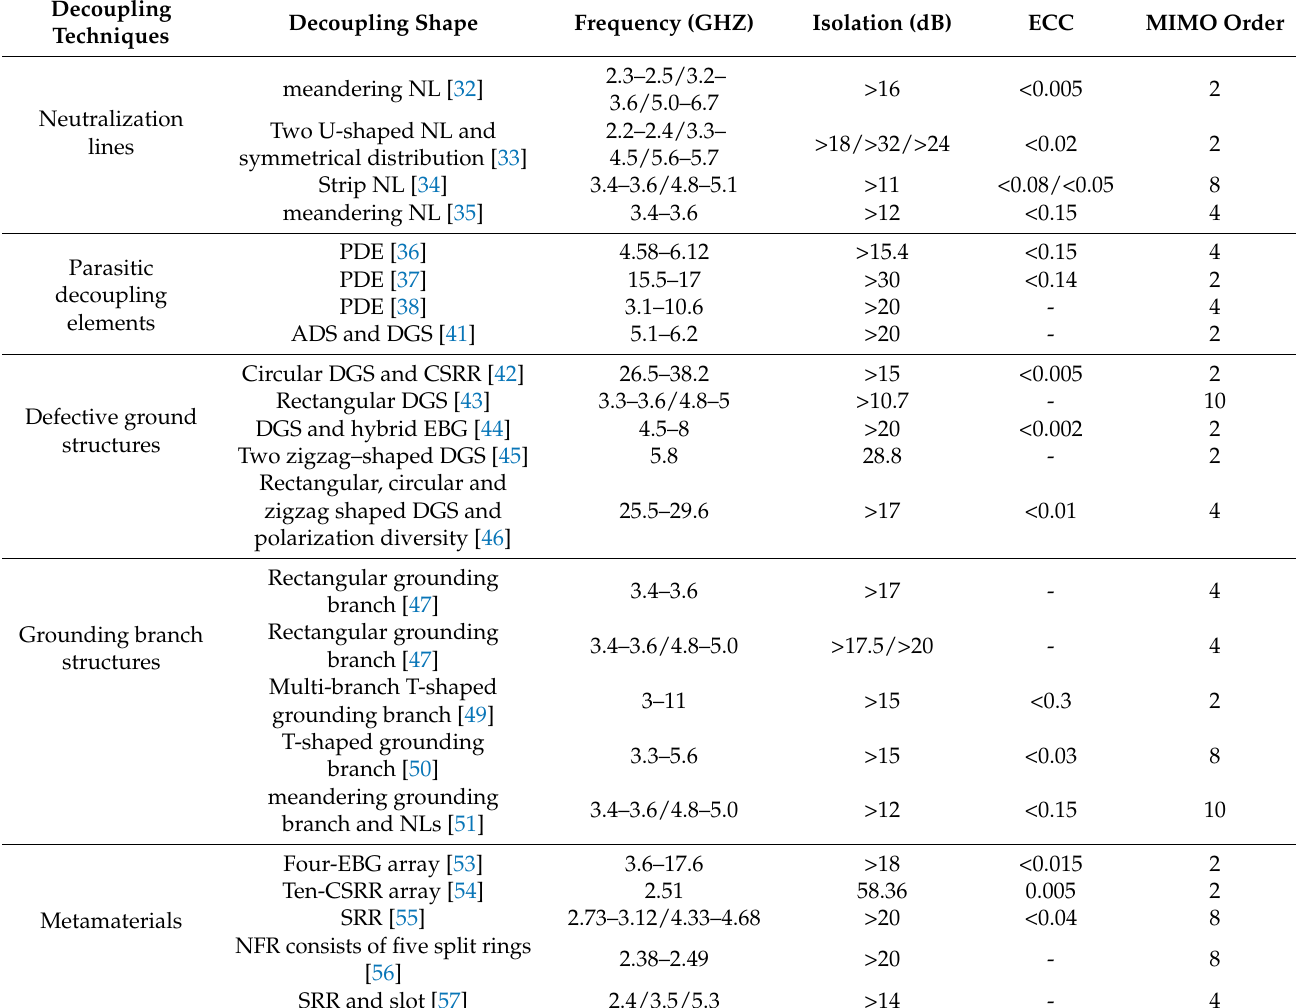
Table 2. Comparison among the referenced techniques of external